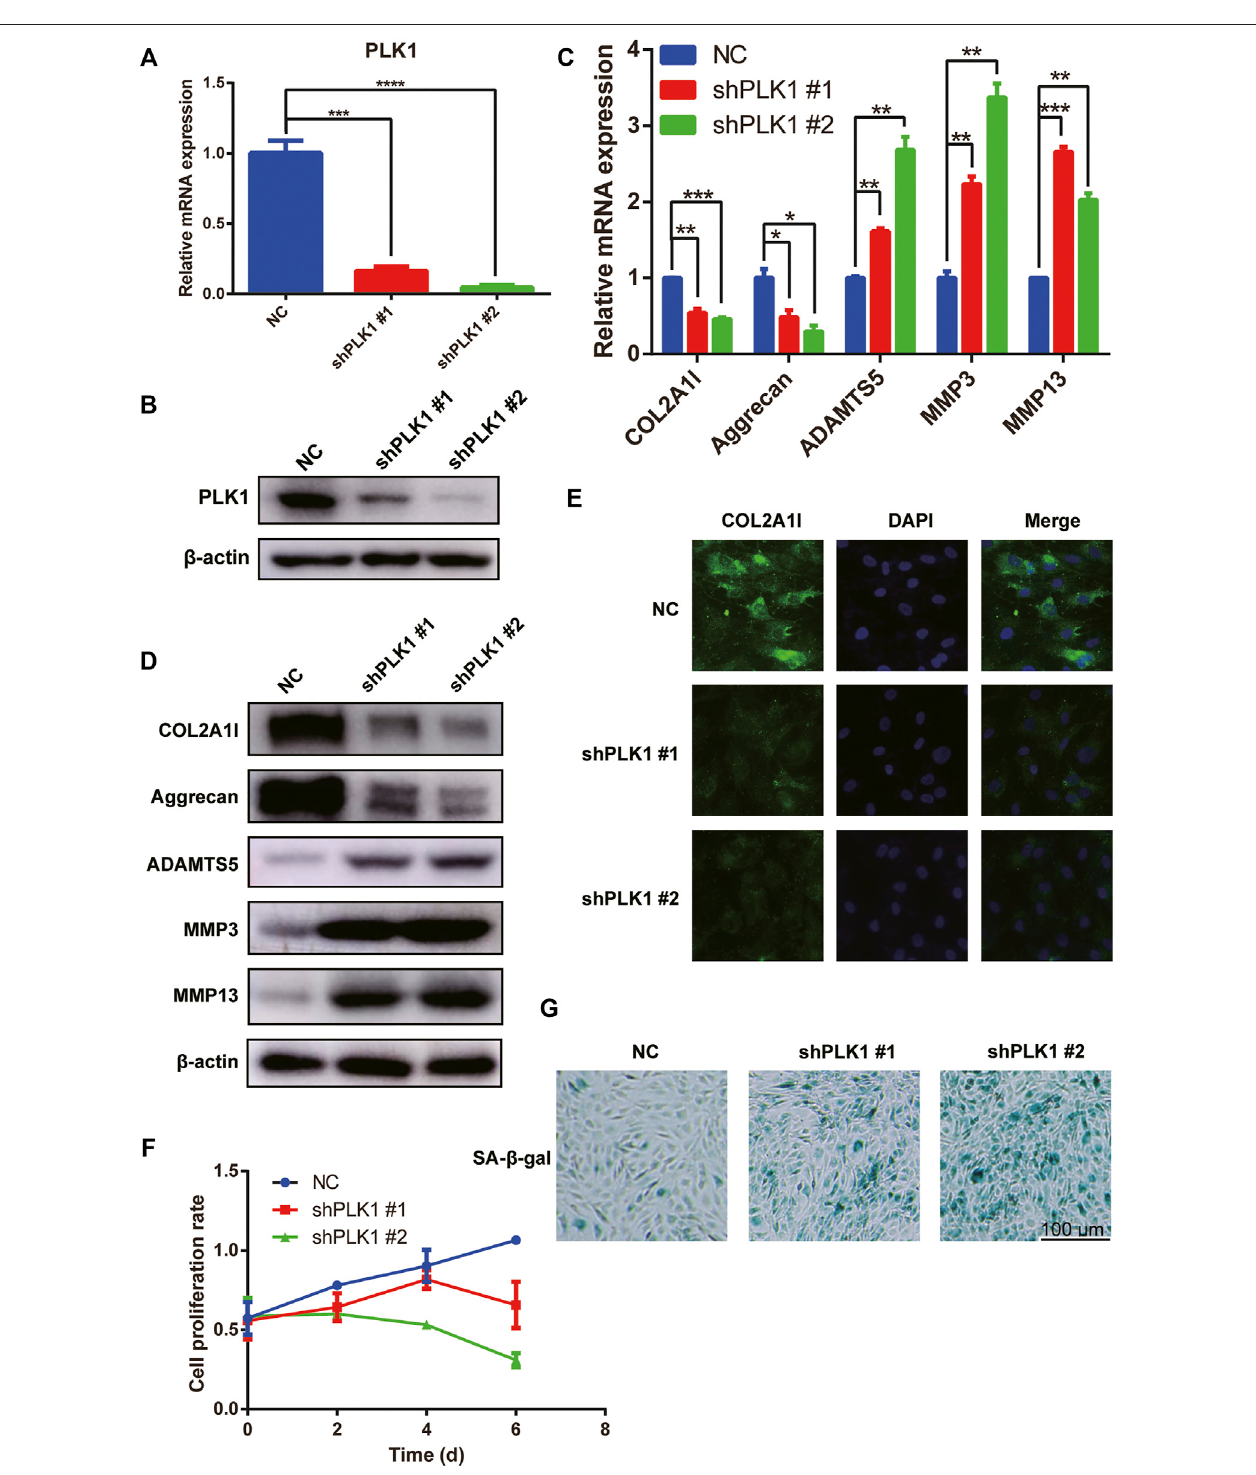
FIGURE 2 | PLK1 knockdown inhibits proliferation and induces senescence in NPCs. (A,B) The ef fi ciency of PLK1 shRNAs. (C,D) The mRNA and protein expressionofcollagen,aggrecan,ADAMTS5,MMP3,andMMP13afterknockingdownPLK1inNPCs. (E) Thecollagenwasdetectedbyimmuno fl uorescence,andblue fl uorescence represents the nucleus, and green fl uorescence represents collagen. (F) CCK8 assay was used to detect cell proliferation at the 0, 2nd, 4th, and 6th day after steadily knocking down PLK1 using shRNA. (G) Senescence of NPCs was measured by SA- β -Gal assay after knockdown by PLK1 shRNA in NPCs. All experiments were performed in duplicates, and data are reported as the mean ± SD. * p < 0.05, ** p < 0.01, *** p < 0.001, **** p < 0.0001. SD, standard deviation.